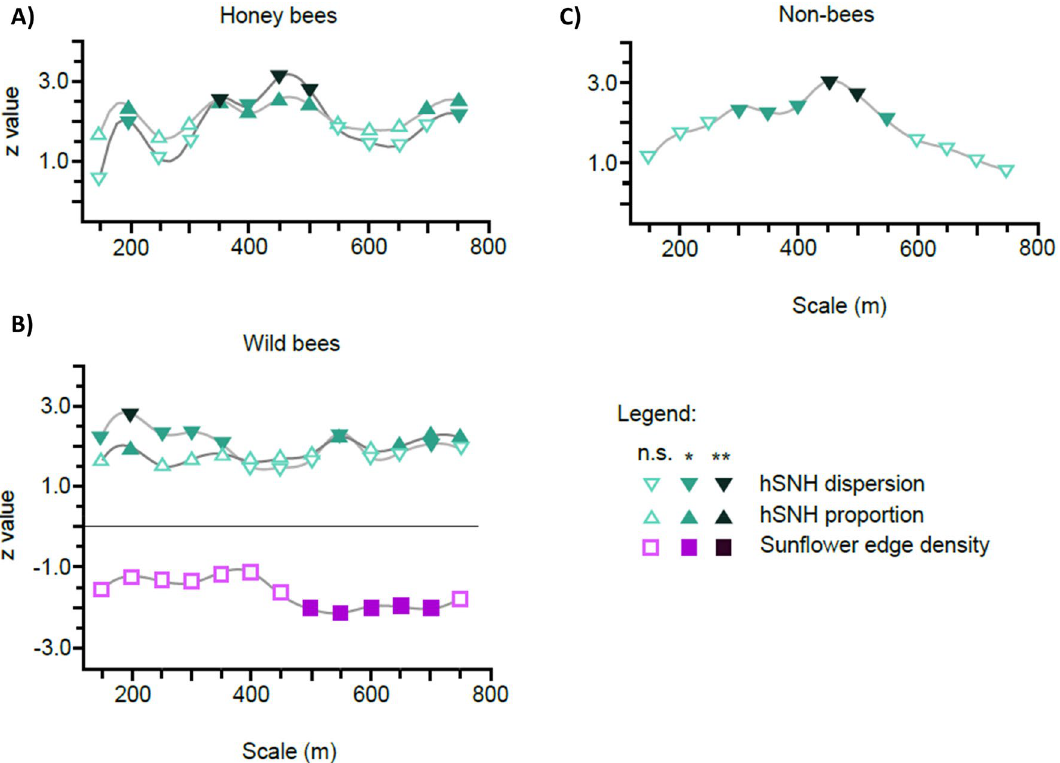
Figure 1. Z-values taken from generalized linear mixed models (GLMMs) assuming a Poisson distribution. The Poisson GLMMs tested for the effects of three different landscape metrics of hSNH patches and sunflower fields over 13 spatial scales (150–750 m) on the sunflower visiting frequency of ( A ) honey bees, ( B ) wild bees and ( C ) non-bees. From the three tested metrics only those having significant effects are presented in the figures. For the coefficients of the Poisson GLMMs with all metrics see Tables S4–S6. Trend lines were fitted among the points to make changes in the trend of the z-values more apparent. The intensity of coloration represents statistical significance (n.s. = not significant; * ≤ 0.05; ** ≤ 0.01).